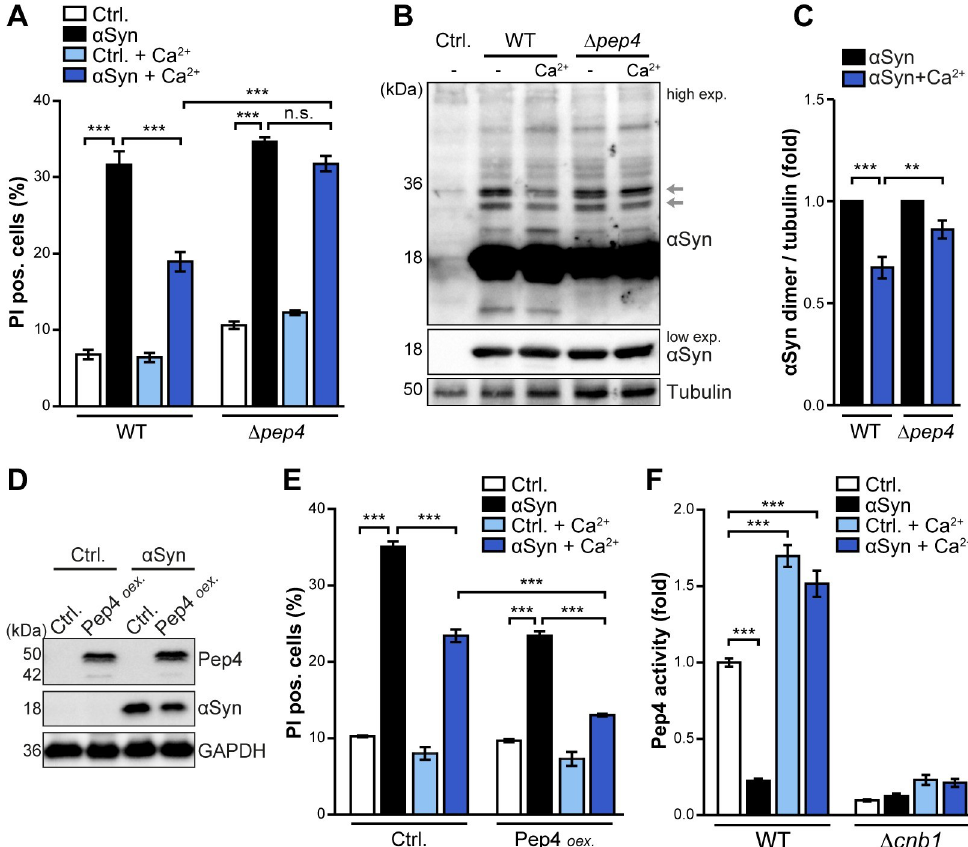
Fig 5. Ca 2+ -addition triggers calcineurin-dependent hyperactivation of Pep4. ( A ) Cell death determined by propidium iodide (PI) staining of WT and Δ pep4 cells, expressing α Syn for 36 h or harboring the vector control (Ctrl.) with or without addition of 10 mM Ca 2+ . Means ± s.e.m; n = 4. ( B, C ) Representative semi-native immunoblots of protein extracts of cells grown on media with and without additional 10 mM Ca 2+ for 36 h (B) and corresponding densitometric quantification (C) of dimeric α Syn species (as indicated by arrows in (B)). Blots were probed with antibodies directed against α Syn and tubulin as loading control, and the combined signal of the dimeric α Syn species was normalized to tubulin. Means ± s.e.m; n = 5. ( D ) Immunoblot analysis of protein extracts from cells expressing α Syn and additionally overexpressing Pep4 (Pep4 oex .) under the control of a galactose promoter. Blots were probed with antibodies against FLAG-tagged α Syn and Pep4, as well as GAPDH as loading control. ( E ) Cell death determined by PI staining of cells described in (D). Cells were treated with 10 mM Ca 2+ at the time point of induction of galactose-driven expression of α Syn and Pep4 (Pep4 oex .). Means ± s.e.m; n = 4. ( F ) Biochemical measurement of Pep4 proteolytic activity in WT or Δ cnb1 cells expressing α Syn for 16 h or harboring the vector control with or without addition of 10 mM Ca 2+ . Means ± s.e. m; n = 4. � p < 0.05, �� p < 0.01, ��� p < 0.001, and n . s . not